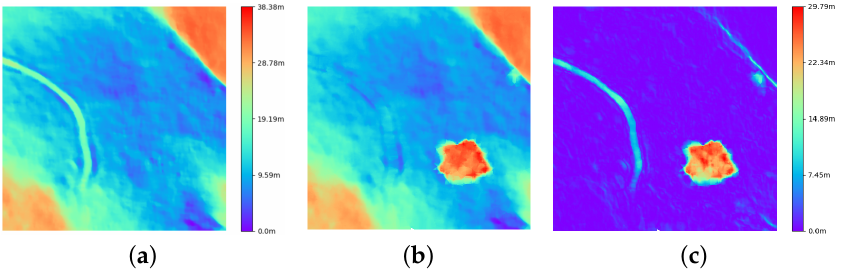
Figure 9. The left and the middle show the DTM ground truth and the one obtained with the best set of parameters of Table 6, respectively. The right shows the error (calculated as the difference between the other two maps) in the DTM estimation. ( a ) Ground-truth DTM. ( b ) Estimated DTM. ( c )